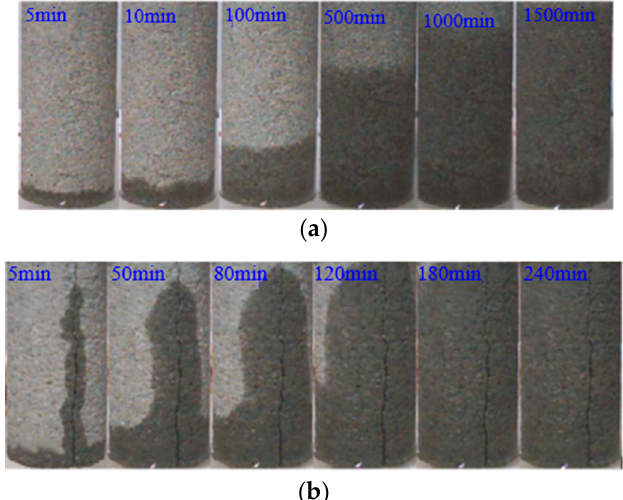
Figure 13. Images of imbibition rate of water in tight cores: ( a ) Core without fractures, ( b ) core with fractures.